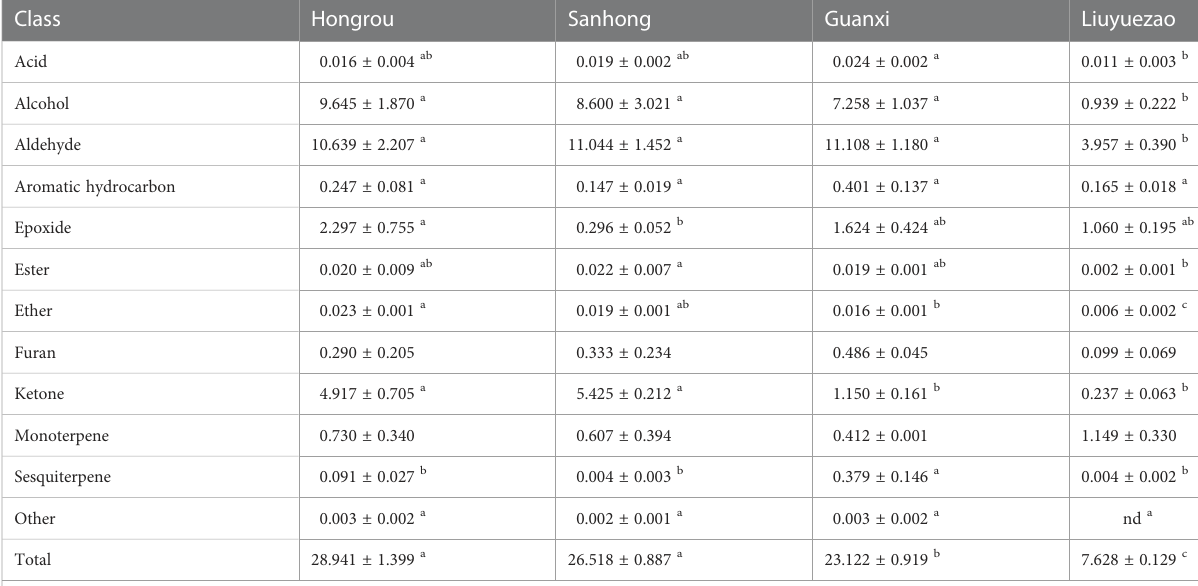
All values are mean ofthreesamples per cultivar;different letters inthe samerows within each tissue indicate signi fi cant differences according toTukey ’ shonestly signi fi cant difference test at P <